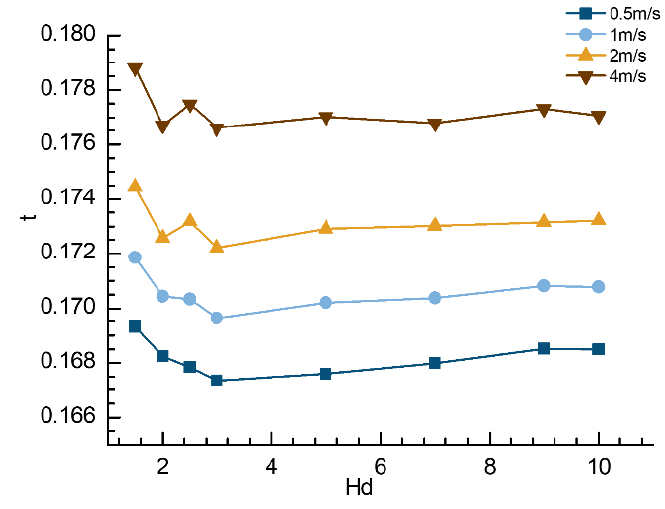
Figure 14. Thrust reduction for self-propelled UUV.